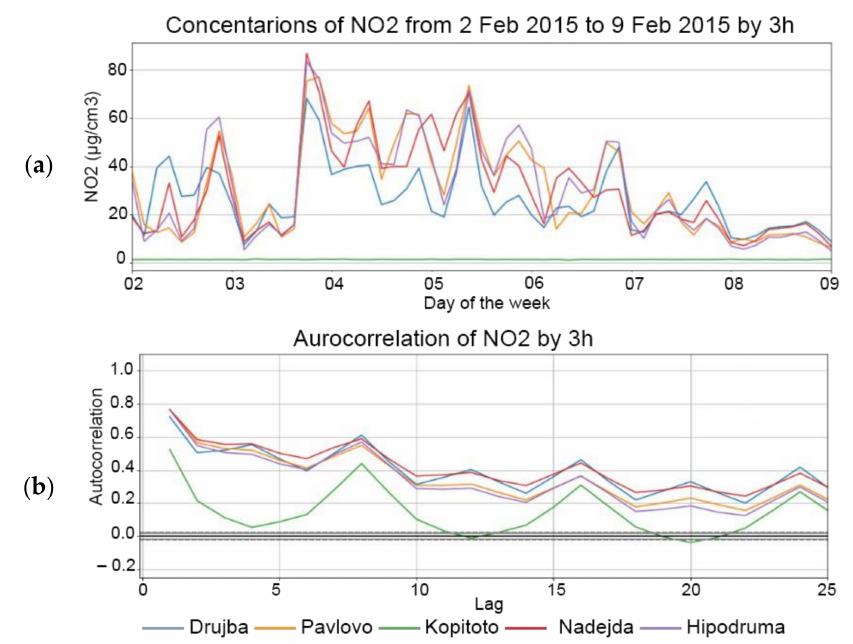
Figure 6. The signal for the different stations corresponding to NO 2 measured by 3 h ( a ) and the corresponding autocorrelation ( b